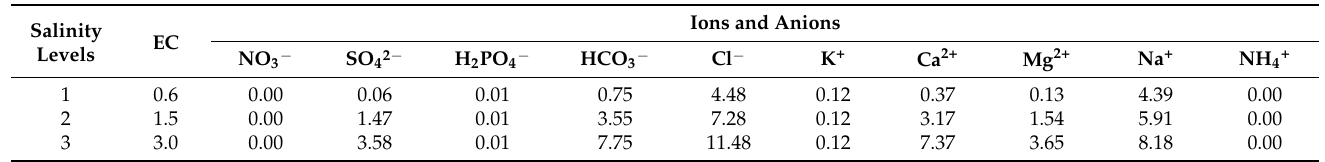
Table 2 shows the ion composition of the different types of irrigation water. Table 2. Water ion composition of the three types of irrigation water. EC, electric conductivity for treatment (dS m − 1 ); ions and anions of interest for irrigation (mmol l − 1 ).